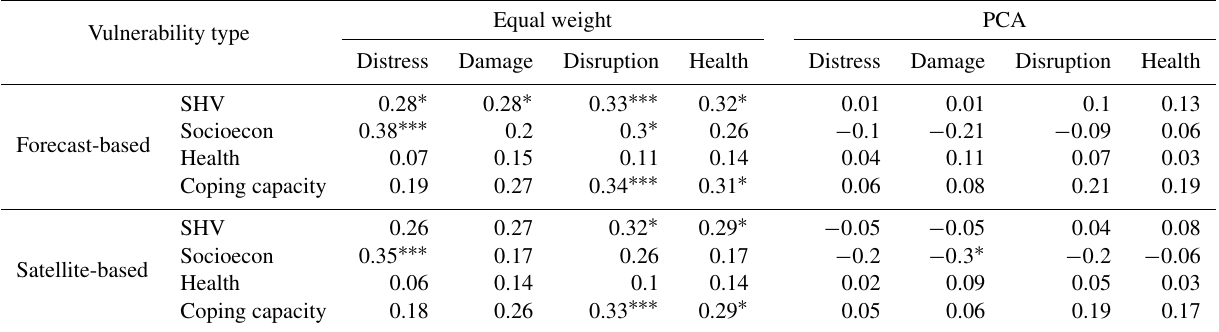
Table 4. Correlation between SHV and domain vulnerability and observed flood impact indices. Equal weight PCA Vulnerability type Distress Damage Disruption Health Distress Damage Disruption Health